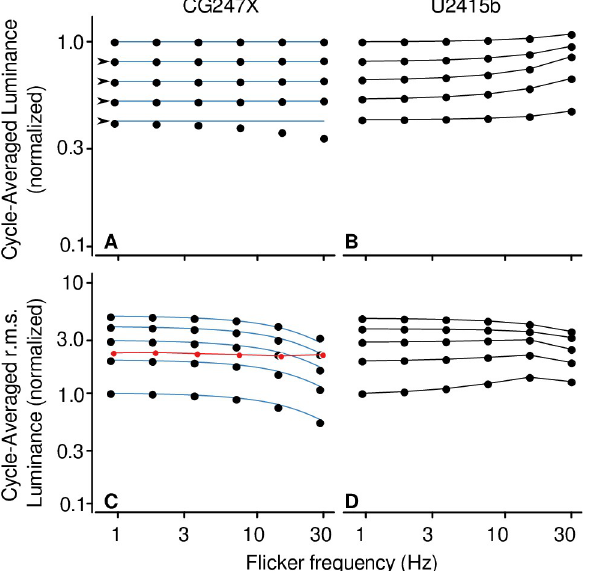
Fig 8. Cycle-averaged luminance and root-mean-squared luminance of mean-modulated flicker. We presented mean-modulated flicker at a range of flicker frequencies (0.94 to 30 Hz) and contrasts (20 to 100%). We used waveforms (e.g., Fig 6) recorded from the CG247X ( A ) to derive cycle-averaged luminance; we divisively normalized that derived measure using the cycle-averaged luminance of a “reference” waveform, that is, the response to contrast = 20% and flicker frequency = 0.94 Hz. This relatively low-contrast, low-frequency waveform was chosen as reference because it should be easily realized by both displays. For clarity, cycle-averaged responses for contrast = 40, 60, 80, and 100% are offset by -0.1, -0.2, -0.3, and -0.4 log units, respectively (arrowheads). As shown, cycle-averaged luminance was approximately constant for contrast = 20 to 80% at all flicker frequencies tested (0.94 to 30 Hz). At contrast = 100%, cycle-averaged luminance decreased with flicker frequency. Cycle-averaged luminance recorded from the consumer-grade U2415b ( B ) increased with flicker frequency at all contrasts tested. Graphical conventions are as in A. We used waveforms recorded from the CG247X ( C ) to derive cycle-averaged r.m.s. luminance; we divisively normalized that derived measure using cycle-averaged r.m.s. luminance of the reference waveform (20%, 0.94 Hz). As shown, at all contrasts tested (20 to 100%), cycle-averaged r.m.s. luminance decreased with flicker frequency, indicative of a loss of effective contrast. Cycle-averaged r.m.s. luminance recorded from the U2415b ( D ) revealed both increases and decreases to effective contrast with flicker frequency. Each symbol is the average of 10 measurements. (None of the data in panels C and D is offset.) We modeled cycle-average luminance and r.m.s. luminance on the CG247X as a causal exponential decay (Methods). This model comprised one free parameter, τ . For the illustrated fit (blue), τ = 6.6 ms. The red symbols in panel C (slightly offset rightward for clarity) show the result of a validation experiment (see Discussion ), wherein we used our model to stabilize cycle-averaged r.m.s. luminance across flicker frequency. Each red symbol is the average of six